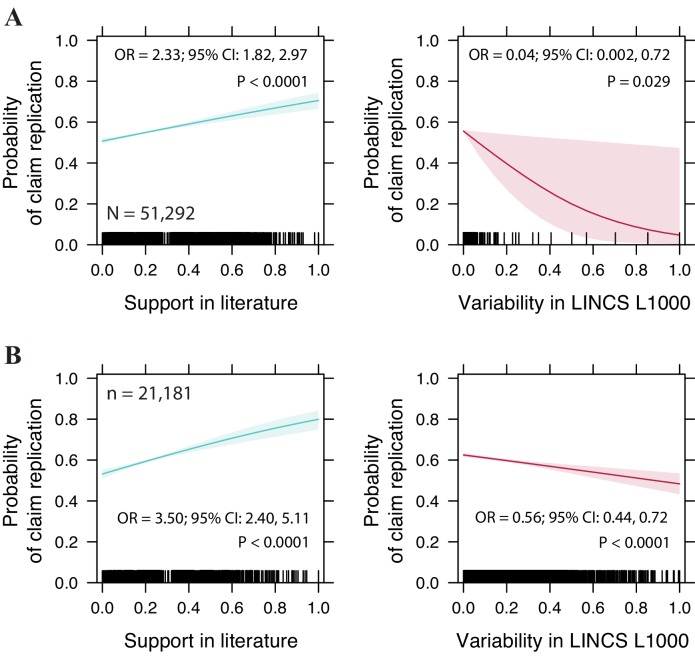
Description of claim types in the whole corpus of 51,292 claims.(A) Mean number of findings supporting or opposing the direction of the effect for a scientific claim across our typology. (B) Cumulative distribution of the probability of support in the literature, including a schematic of our claim typology.